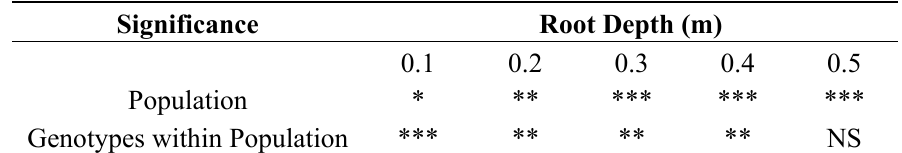
Table 6. Significance levels for effect of population and genotype within population on root dry weight at different depths.